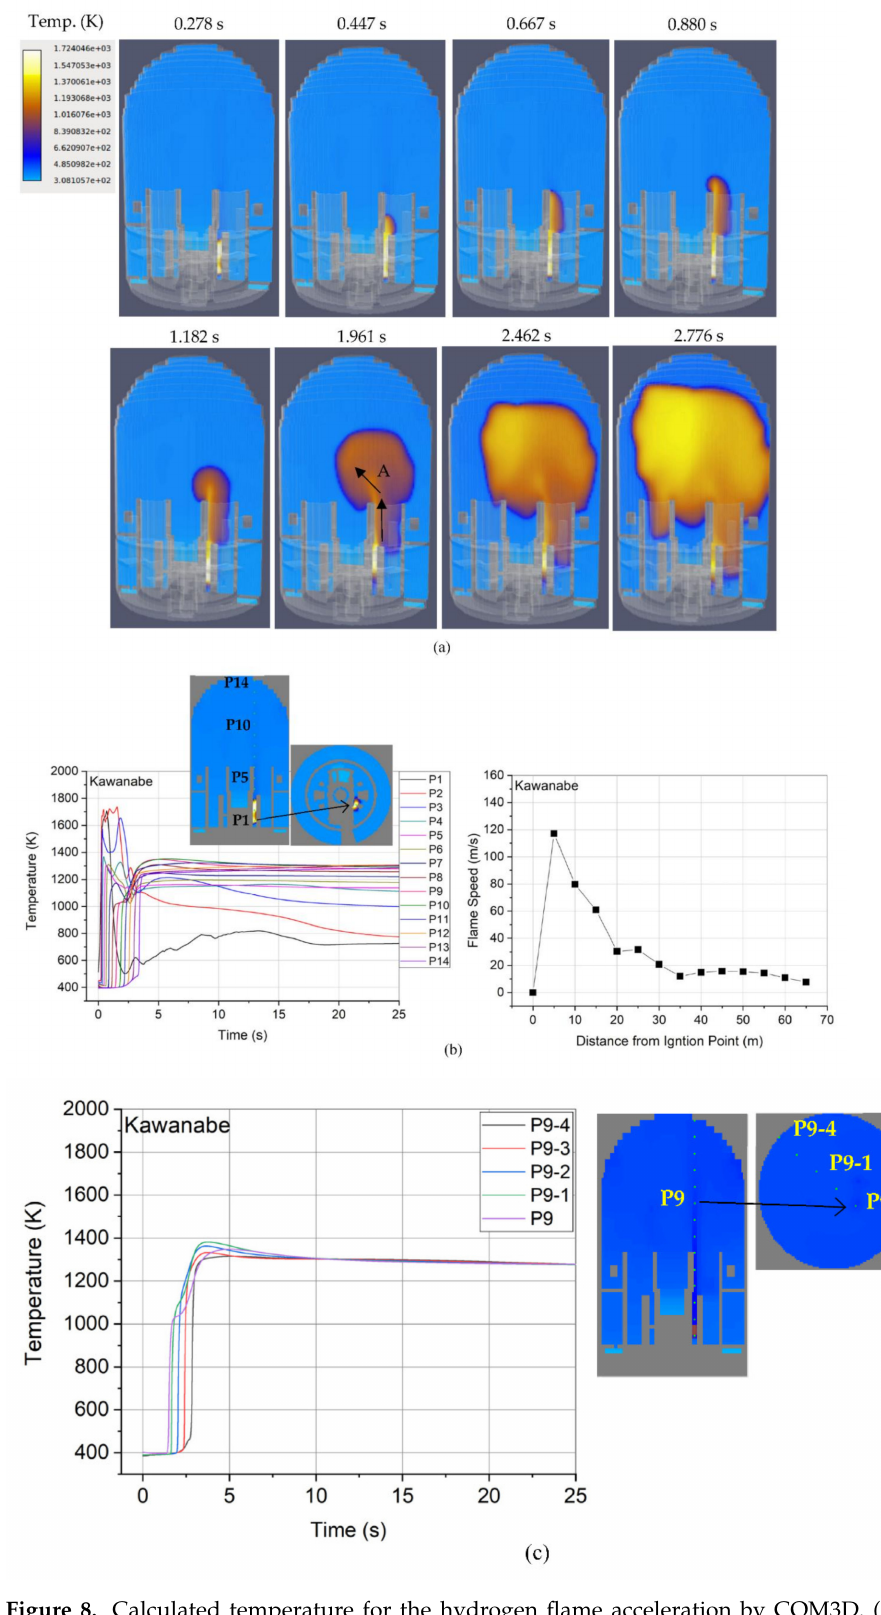
Figure 8. Calculated temperature for the hydrogen flame acceleration by COM3D. ( a ) Temper- ature distribution as time passes. ( b ) Temperature behaviors and flame speeds from P1 to P14. ( c ) Temperature behaviors from P9 to